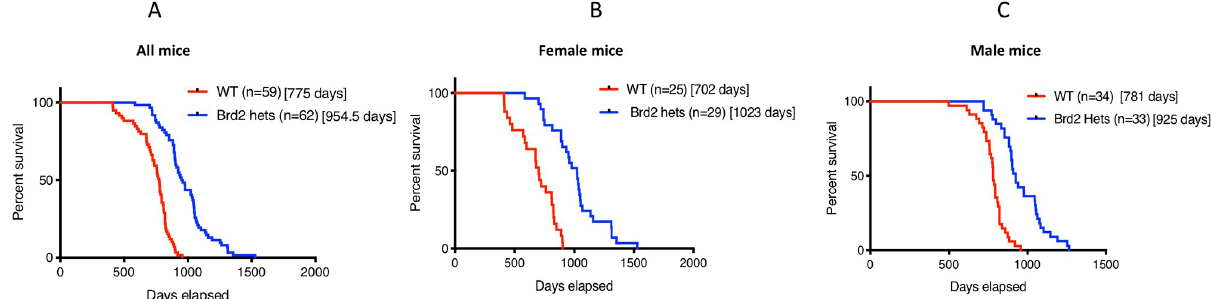
Fig 1. Life span analysis of Brd2 HET mice. Brd2 haploinsufficiency prolongs the life span in our mice colony (A). Panels B and C show the increase survival rates of both female (B) and male (C) mice separately (p < 0.0001 for all groups). The figures in the square bracket indicate median lifespan.